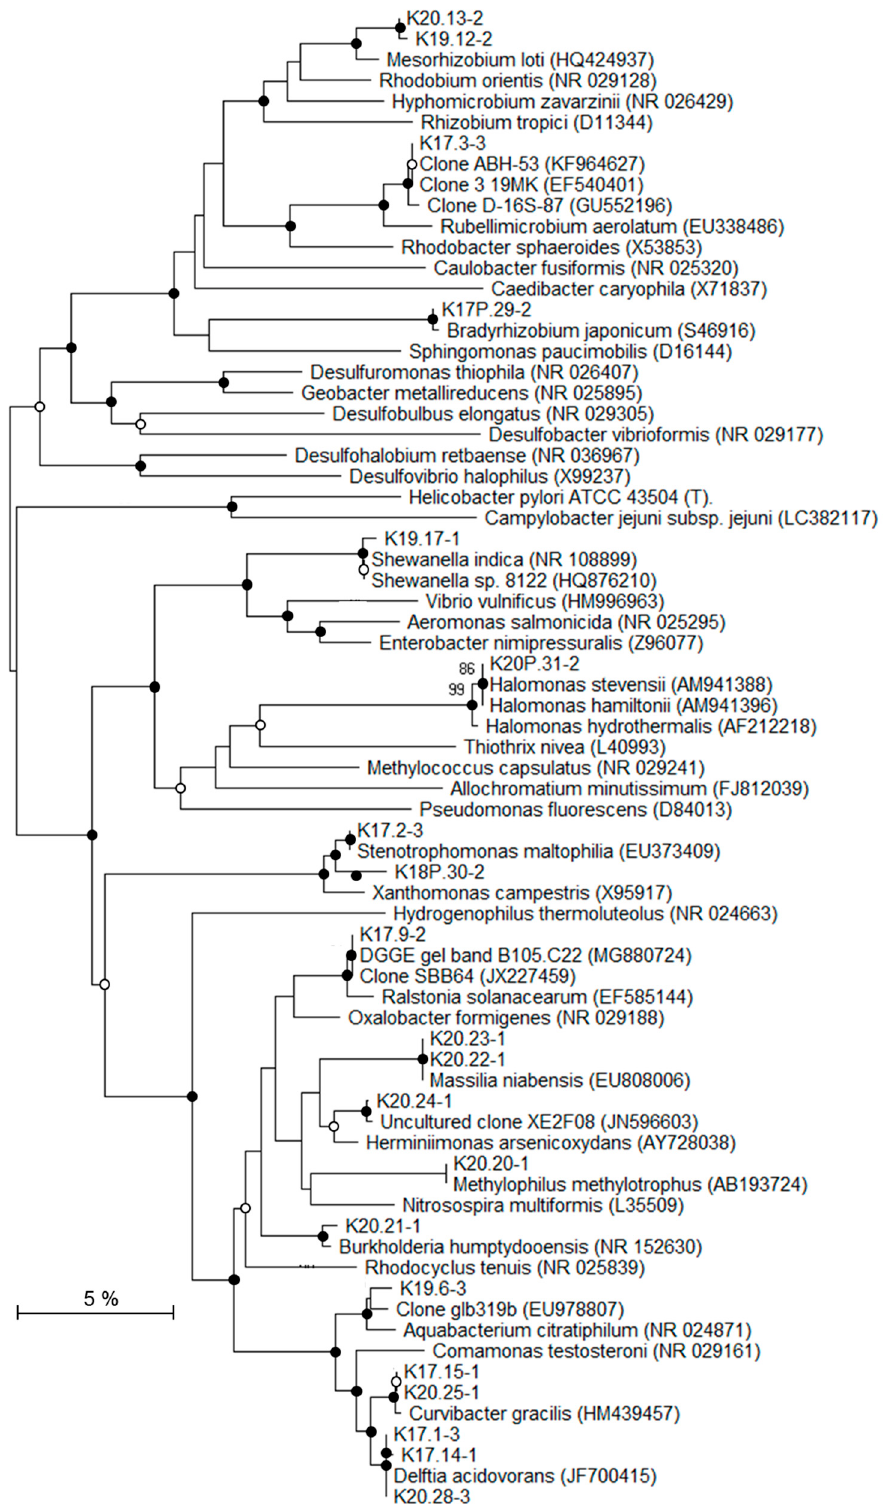
Figure 6. Phylogenetic tree showing the relationships of recovered Proteobacteria -related 16S rRNA gene sequences with reference Genbank sequences. Black circles: bootstrap > 70%; white circles: 50% < bootstrap < 70% (1000 replicates).